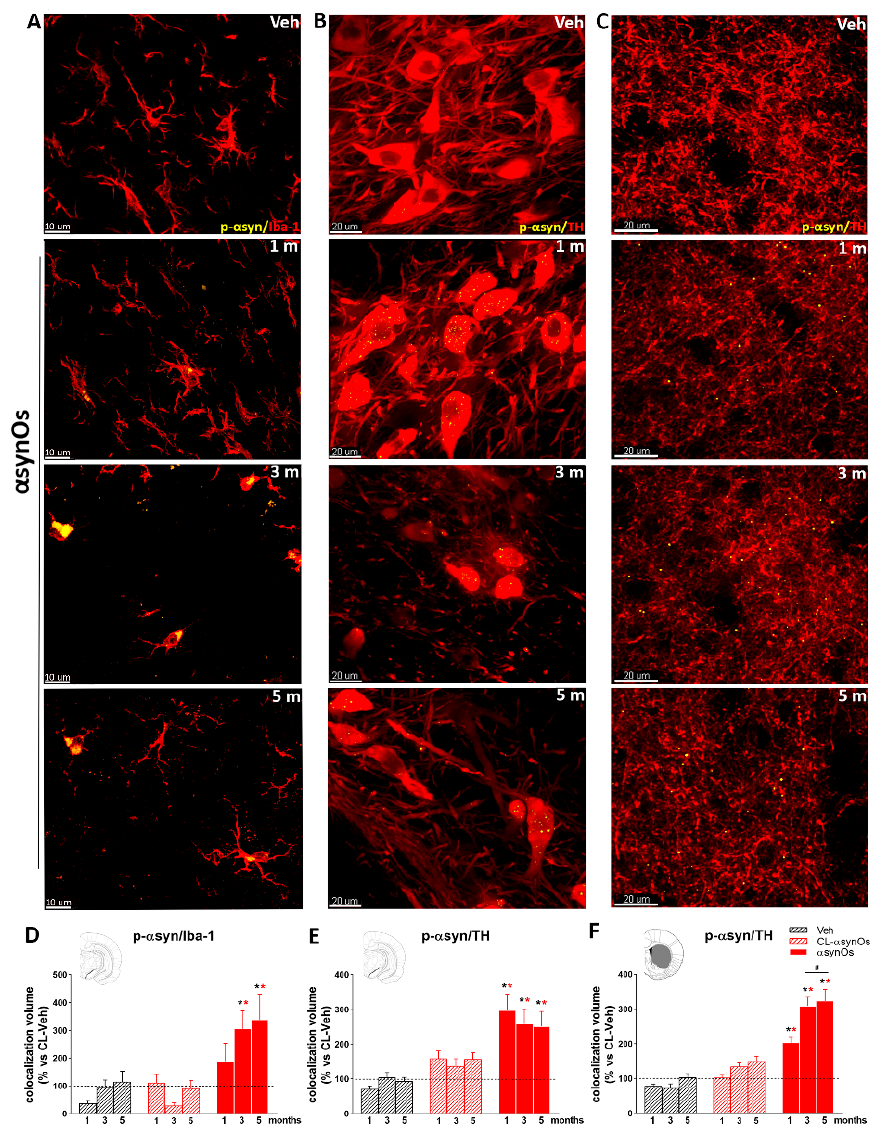
Figure 3. p129- α Syn aggregates in microglia and nigrostriatal neurons. Representative confocal images showing p129- α Syn (yellow) in Iba-1 + cells (red) ( A ), in TH + cell bodies (red) ( B ) of the SNpc, and in TH + fibers (red) of the striatum ( C ). Magnification 63X. Total volume occupied by p129- α Syn colocalized with Iba-1 ( D ) and TH ( E ) in the SNpc and colocalized with TH in the striatum at progressive time points post-infusion ( F ). Values are expressed as a percentage of the contralateral (CL) side of vehicle-injected animals (Veh) and represent the mean ± SEM. * p < 0.01 vs. Veh, * p < 0.001 vs. CL-H- α synOs, # p < 0.0001 vs H- α synOs, one month post infusion, by Tukey post-hoc test ( n = 100–120 per group, 4–5 animals per